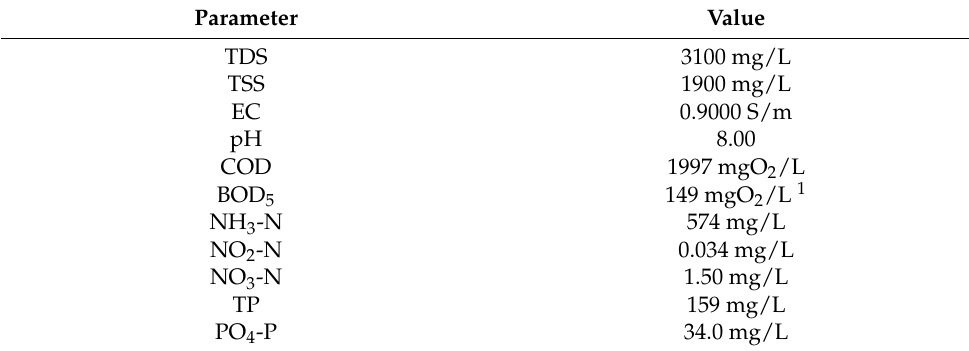
Table 1. Physical and chemical parameter values of the raw piggery wastewater collected from the selected lagoon [36]. TDS: total dissolved solids; TSS: total suspended solids; EC: electrical conductivity; COD: chemical oxygen demand; BOD 5 : 5-day biochemical oxygen demand; NH 3 -N: ammonia nitrogen; NO 2 -N: nitrite nitrogen; NO 3 -N: nitrate nitrogen; TP: total phosphorus; PO 4 -P: